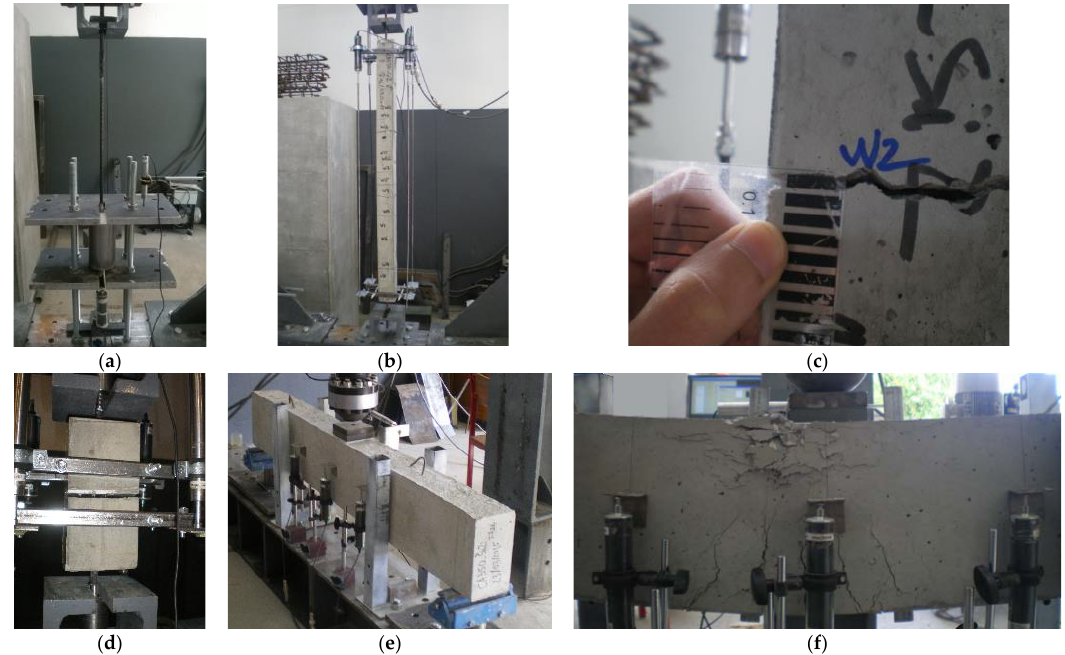
Figure 7. ( a ) Pull-out tests in specimens with nanoparticles addition; ( b ) Tensile tests in RC ties with nanoparticles addition; ( c ) Cracks’ width; ( d ) Pull-out test to study the fibre’s slip; ( e ) Beams’ test set-up; ( f ) Beams’ failure.